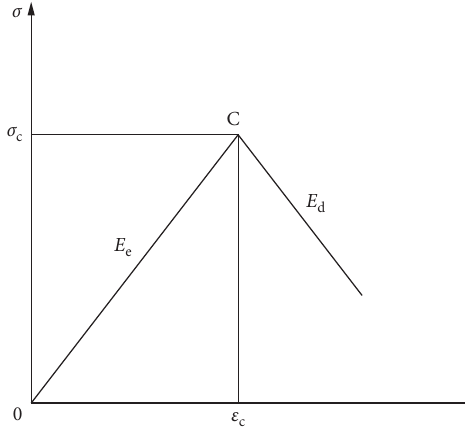
Figure 4: Constitutive relation of coal and